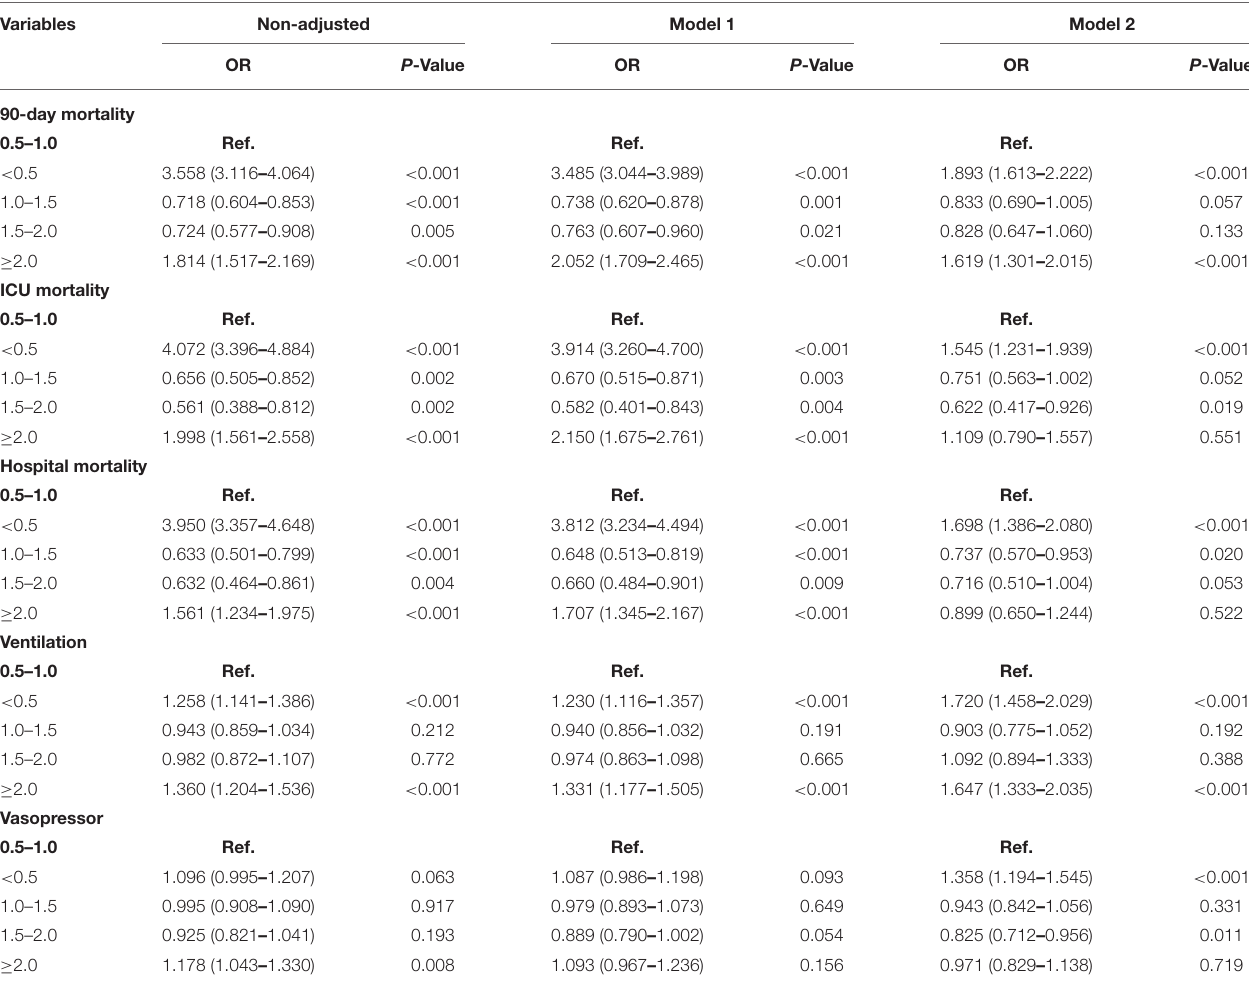
TABLE 3 | Secondary